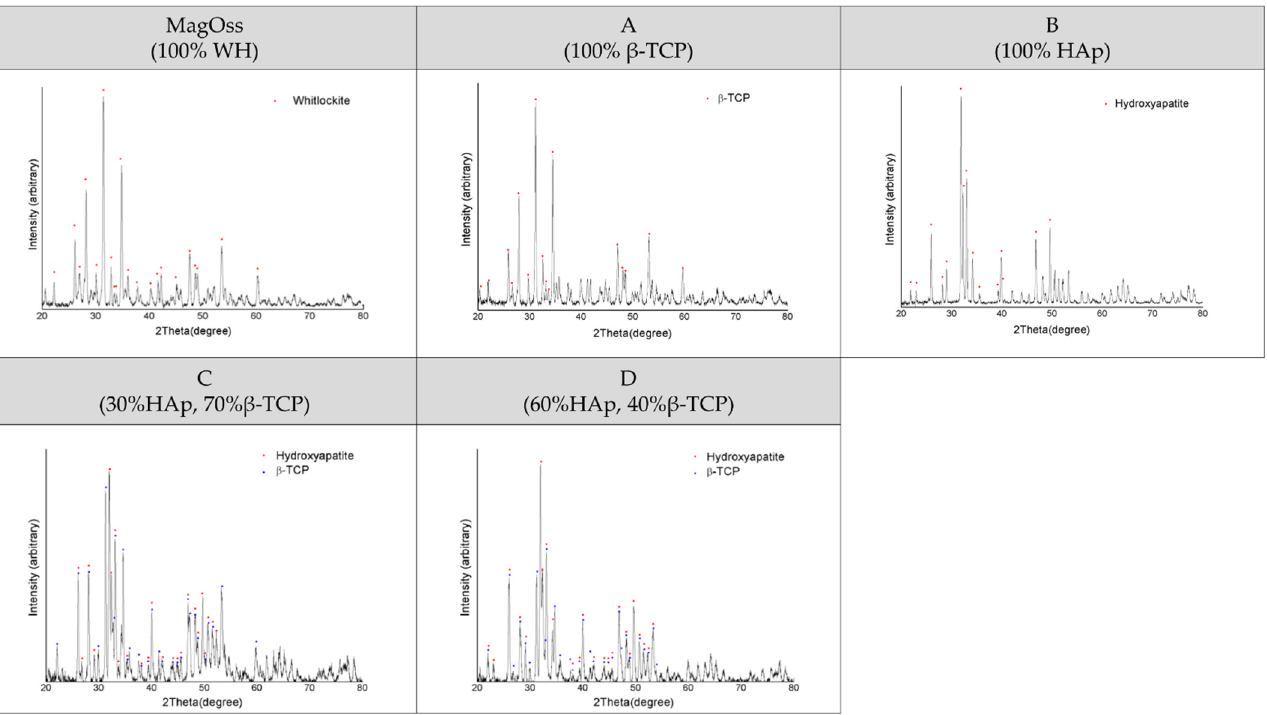
Figure 2. XRD patterns of different bone grafts. These observations were obtained by X-ray diffraction (XRD) analysis. A secondary phase was not found in any of the bone graft products. The XRD pattern of the MagOss group was broader than that of the others. Group A showed the β -TCP pattern, Group B showed the HAp pattern, Group C showed about 30% HAp and about 70% β -TCP, while Group D showed about 40% β -TCP and approximately 60% HAp. A secondary phase was not found. The pattern for Groups A, B, C, and D had a sharper and narrower width than MagOss group.